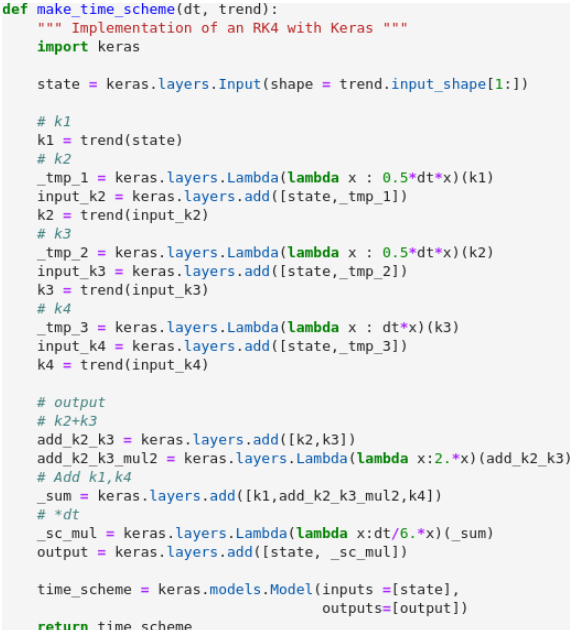
Figure 6. Example of a Keras implementation for an RK4 time scheme: given time step d t and a Keras model trend of the dynam- ics, the function make_time_scheme returns a Keras model im- plementing an